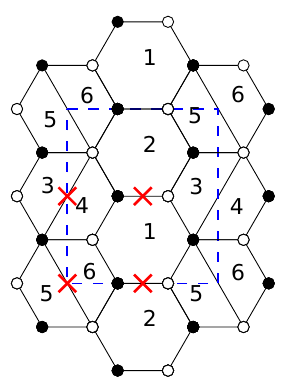
Figure 8 . PdP 3 b dimer with orientifold